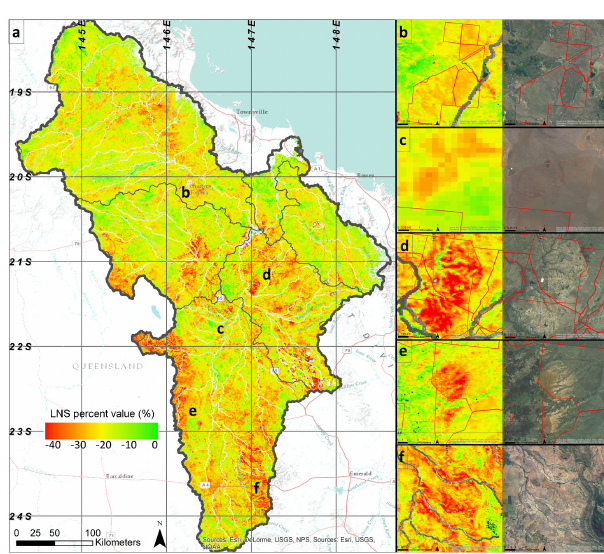
Figure 5. Local net production scaling (LNS) in the Burdekin Dry Tropics (BDT) (a) and enlargements of the areas indicated in (a) : (b) high and low LNS values on either side of a station boundary, (c) variation within a single station showing gradients from low to high, (d) low LNS in eroded drainage area, (e) hillslope erosion re- sulting in bare surface with little to no vegetation cover, and (f) area of tree removal with visible erosion and reduced cover. Black lines are the boundaries of river basins and red lines are station bound-